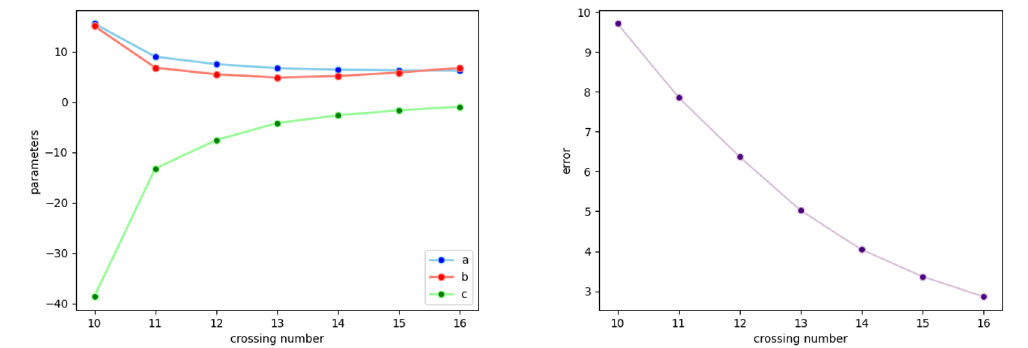
Figure 4 . (Left) Best fit for the hyperbolic volume as a function of | J 2 ( K ; e 3 πi/ 4 ) | . The fitted function (blue) predicts the volume to 97 . 14% accuracy and the neural network trained on the magnitude of J 2 ( K ; e 3 πi/ 4 ) (green) achieves 96 . 55 % accuracy. (Right) Best fit for the hyperbolic volume as a function of | J 2 ( K ; e 4 πi/ 5 ) | . The fitted function (blue) predicts the volume to 96 . 67% accuracy and the neural network trained on the magnitude of J 2 ( K ; e 4 πi/ 5 ) (green) achieves 96 . 30 % accuracy. Both plots display ( J 2 , Vol ) data pairs as a density cloud where darker red regions contain more points.